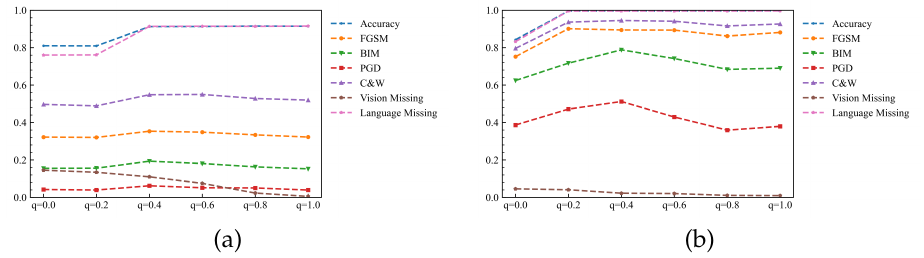
Figure 6. The accuracy trend of the visual modal integrity probability q . ( a ) Birds. ( b )